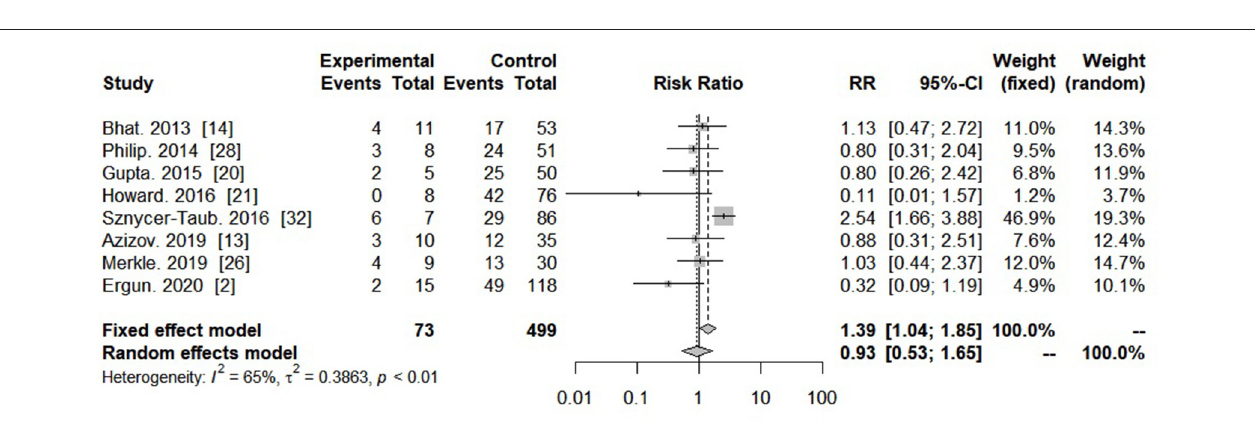
FIGURE 5 | Forest plot showing risk ratio of survival in single ventricle or biventricular physiology with post-cardiotomy extracorporeal membrane oxygenation.